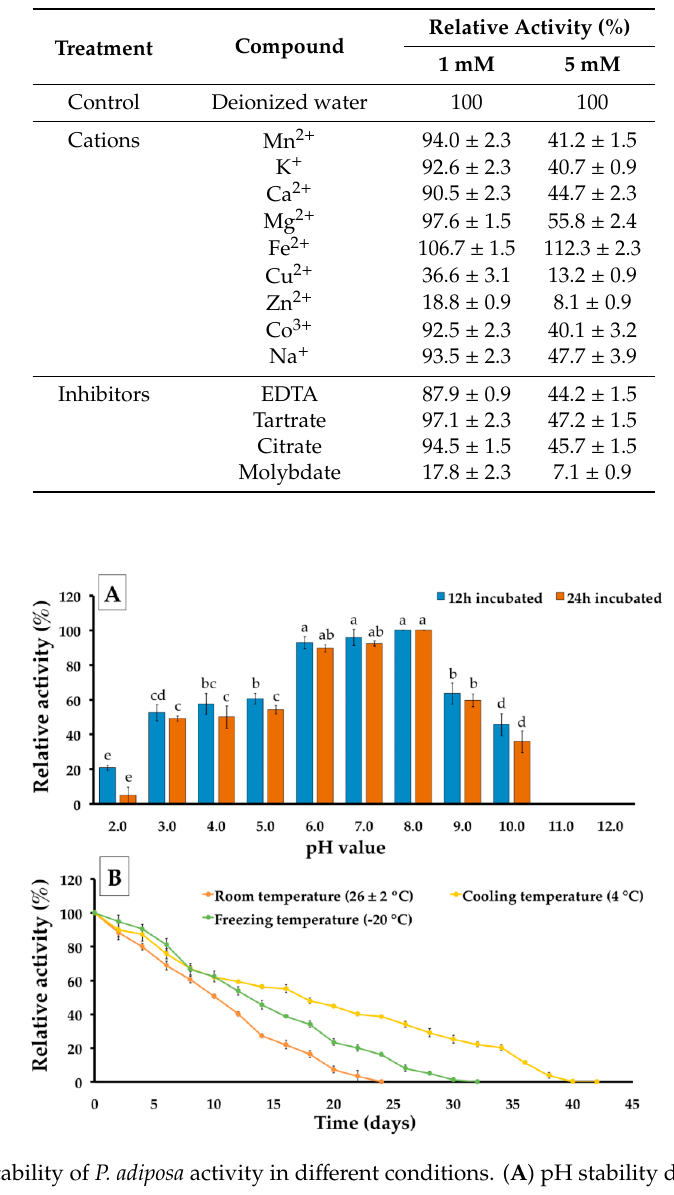
Table 6. E ff ect of cations and inhibitors on P. adiposa phytase.